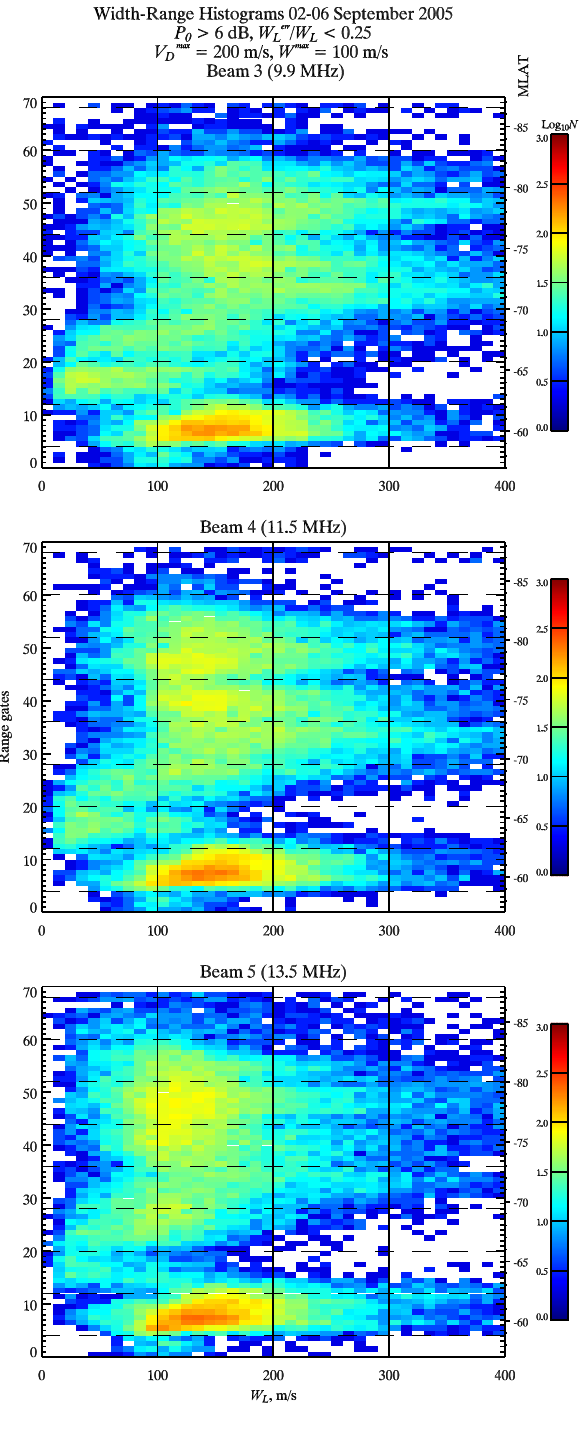
Fig. 8. Spectral width-range gate histograms for 2–6 September 2005.